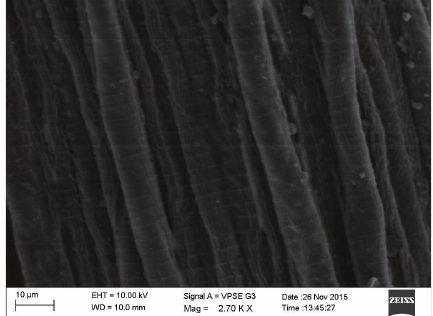
Figure 5: Anterior end of the worm showing thick longitudinal ridges and oral cavity.